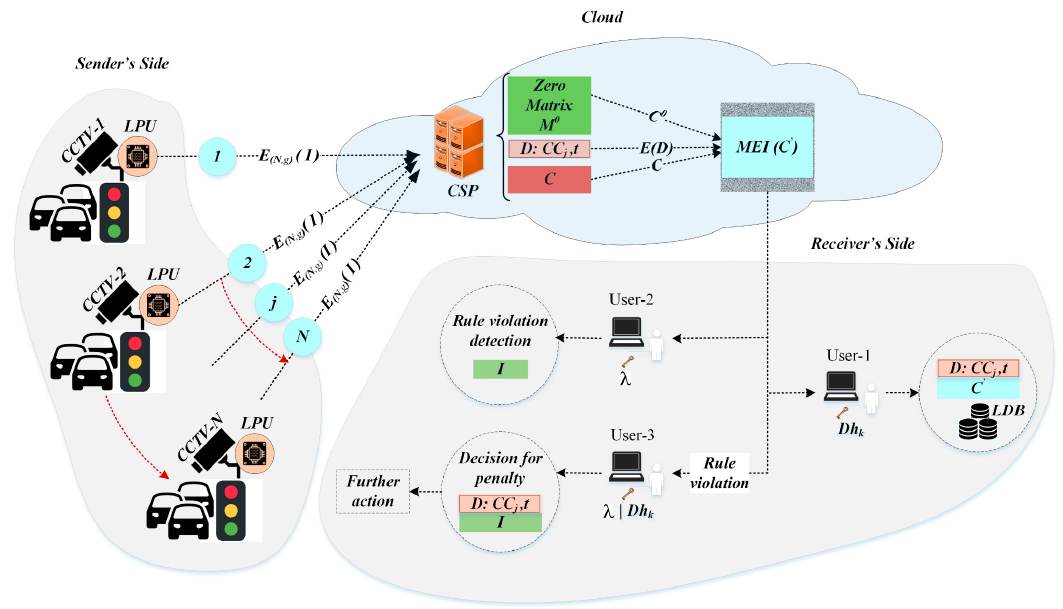
Figure 7. Of the proposed scheme in the cloud scenario.